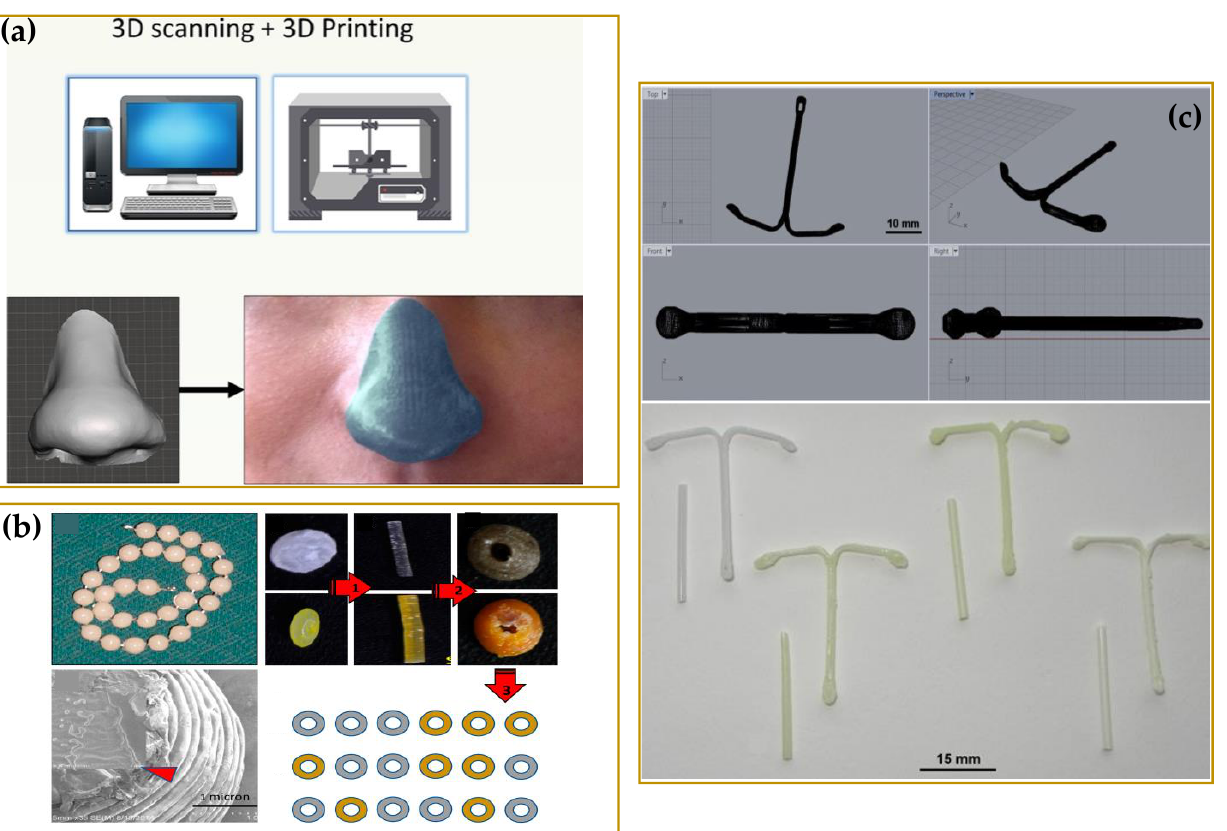
Figure 14. Examples of 3D printed medical devices produced by FFF technique. ( a ) Antimicrobial polycaprolactone wound dressings. Reprinted with permission from reference [165]; copyright (2017) Elsevier B.V; ( b ) Antibiotic loaded implants. Reprinted from reference [167]; copyright (2017). ( c ) Long-lasting implantable drug loaded intrauterine system. Reprinted with permission from reference [164]; copyright (2016) Elsevier B.V.